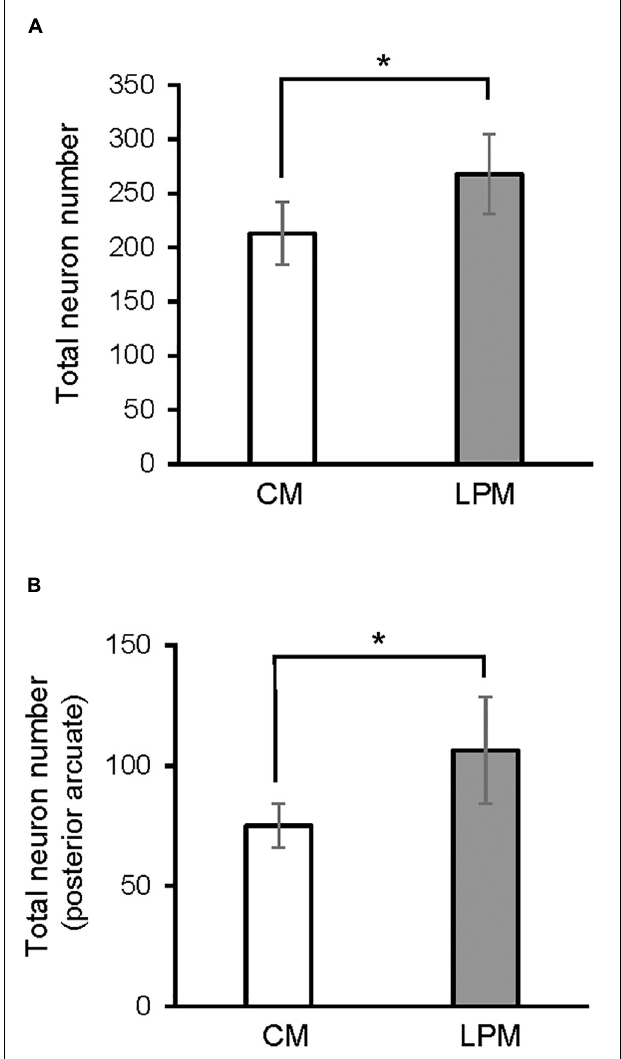
FIGURE 4 | Graph shows the differences in number of neurons in (A) ARC nucleus (B) posterior ARC subdivision in males. CM, control male; LPCM, low-protein and low caloric male. *Significant differences between groups ( p < 0.05 in all cases). All values are expressed as means ±